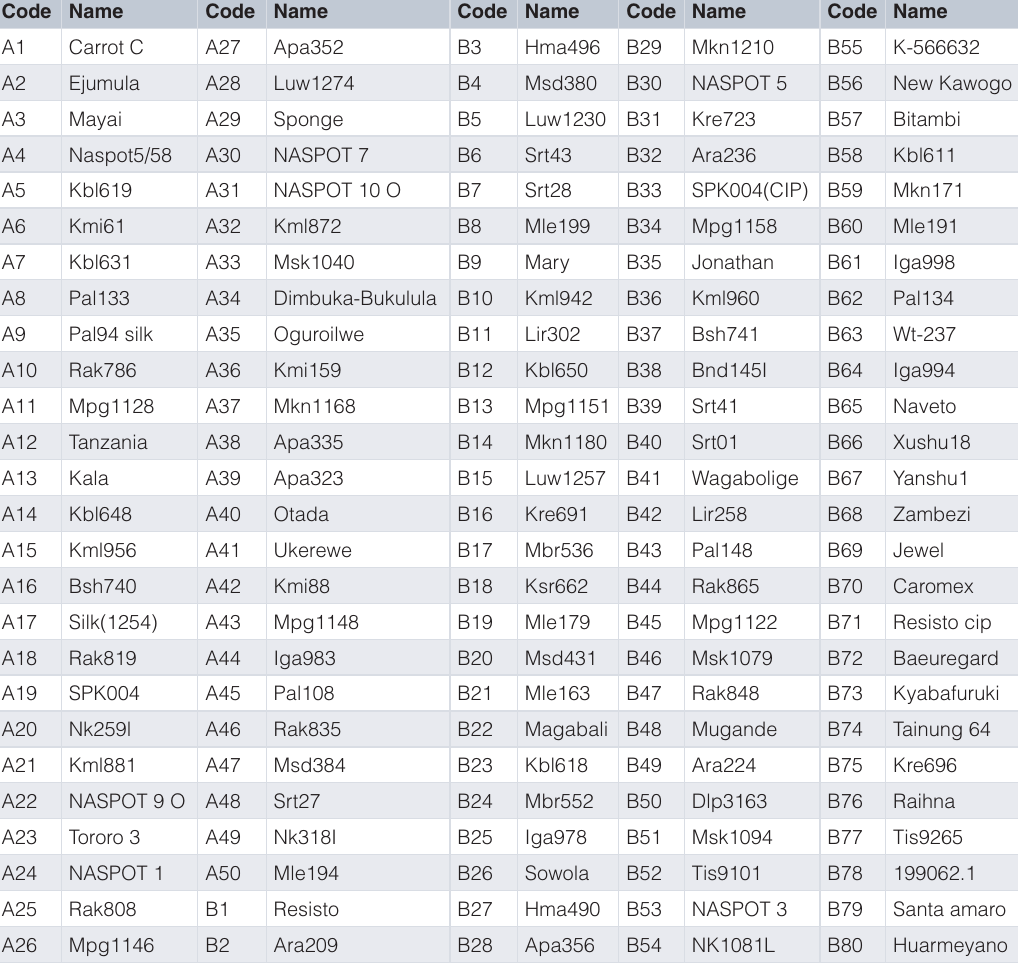
Table 2. List of genotypes screened for continuous storage root formation and bulking in Uganda, 2016 to